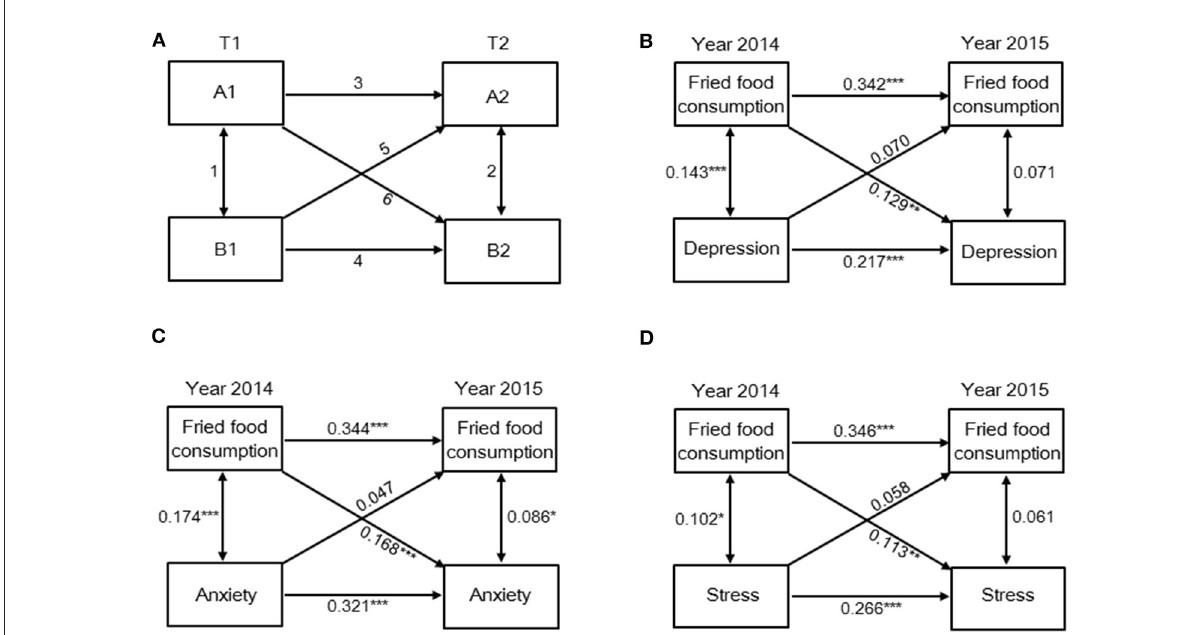
FIGURE1 Fried food consumption is a predictor of depression, anxiety, and stress status a year later. (A) Cross-lagged correlational model describing three types of relationships: 1, 2 = synchronous correlations; 3, 4 = autocorrelations; 5, 6 = cross-lagged correlations. Prospective associations between fried food consumption and status of (B) depression, (C) anxiety, and (D) stress on the DASS-21. * p < 0.05, ** p < 0.01, and *** p <